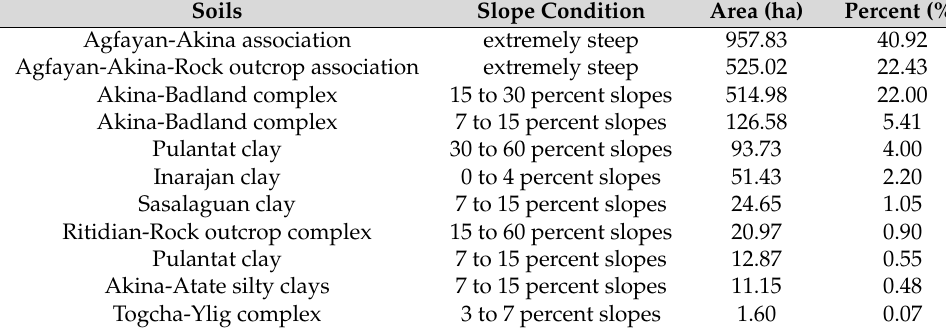
Table 3. Soil types of the Pago